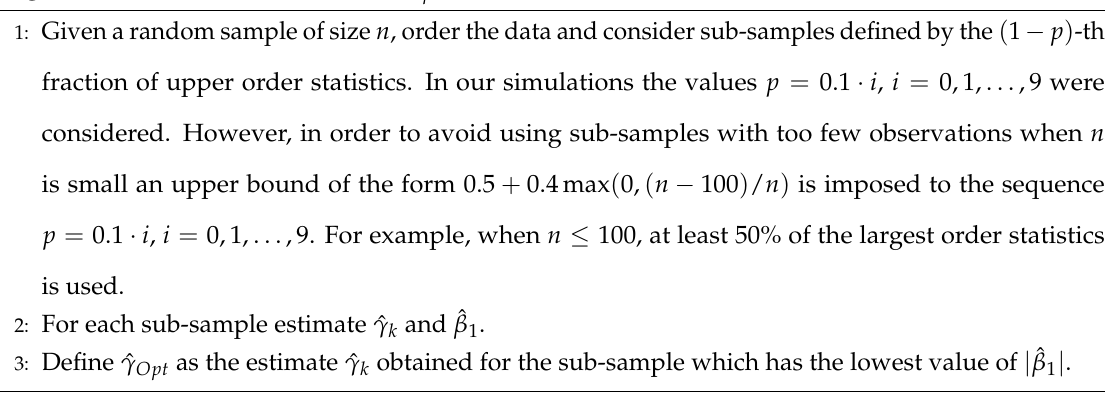
Algorithm 2 Data-driven estimator ˆ γ Opt